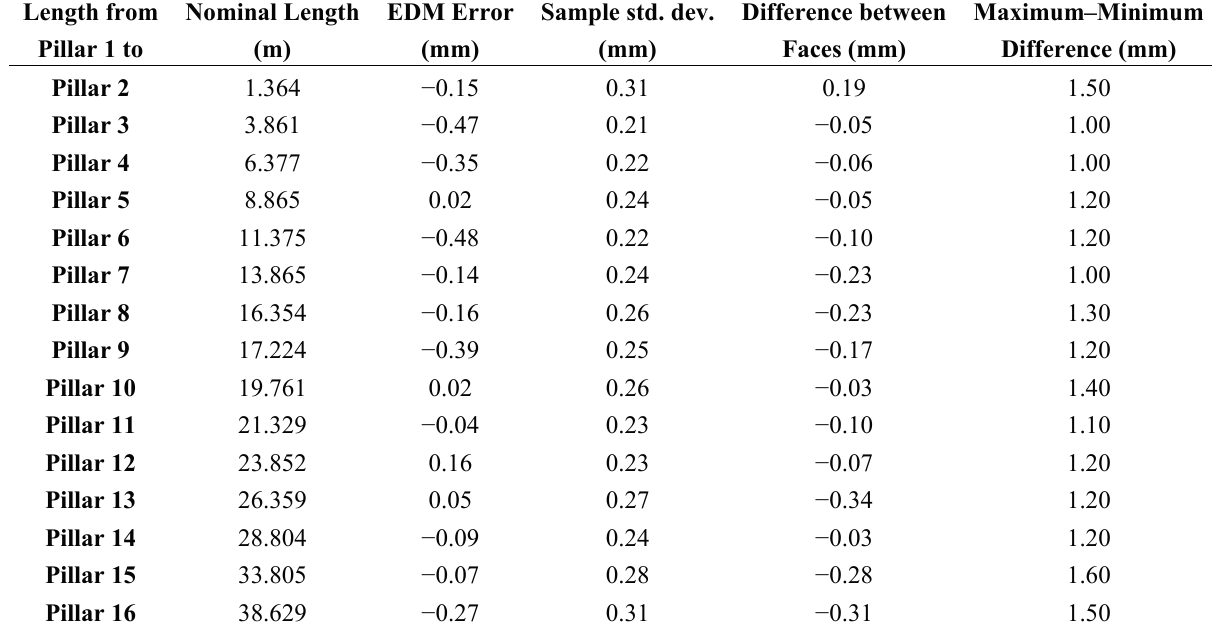
Table 8. Trimble S8 (16 July 2014).